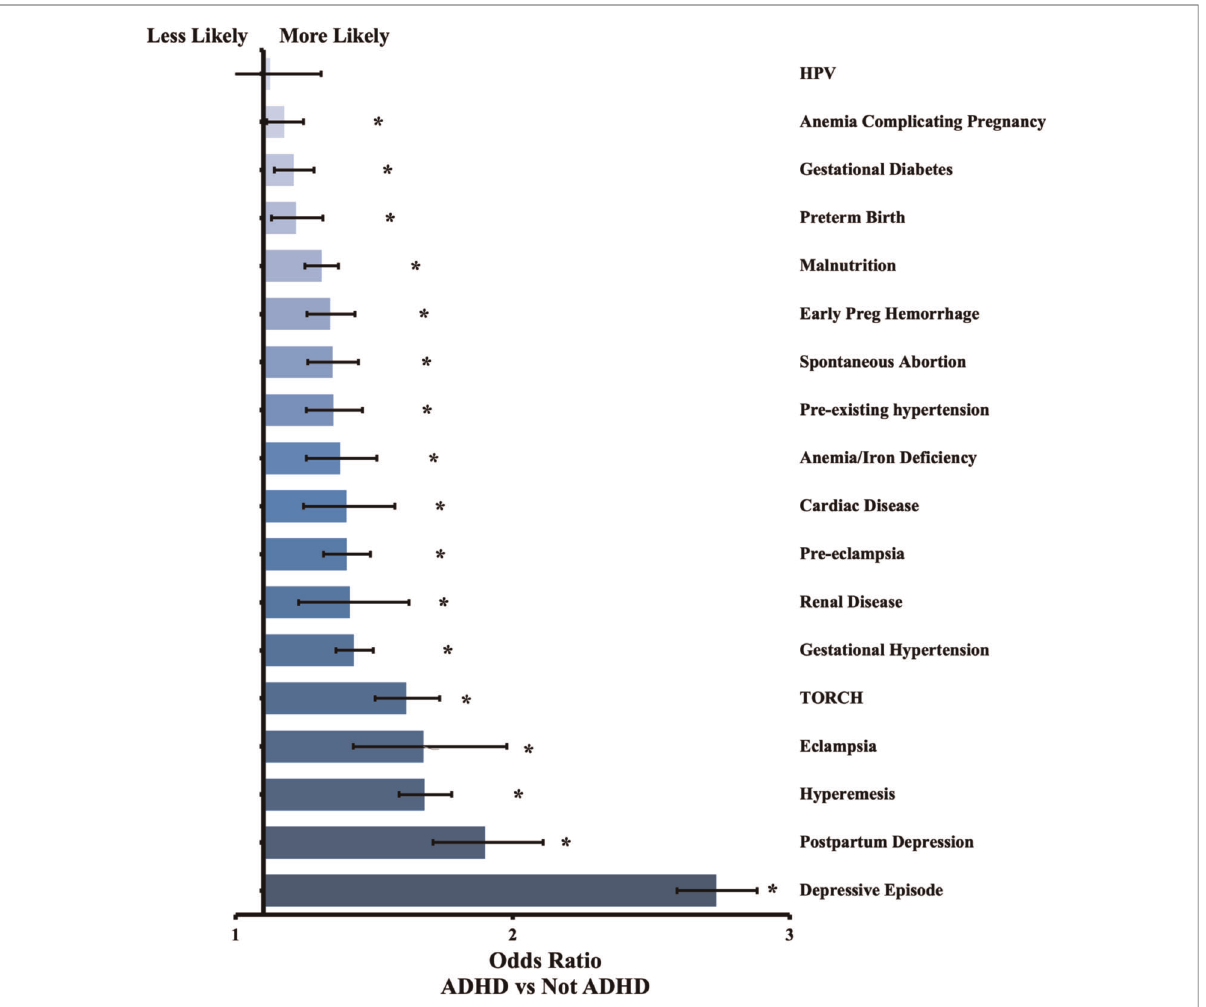
FIGURE 1 Odds ratio by outcome between patients with ADHD and without ADHD. Con fi dence bars represent 95% interval. * data labels indicate signi fi cant difference ( P